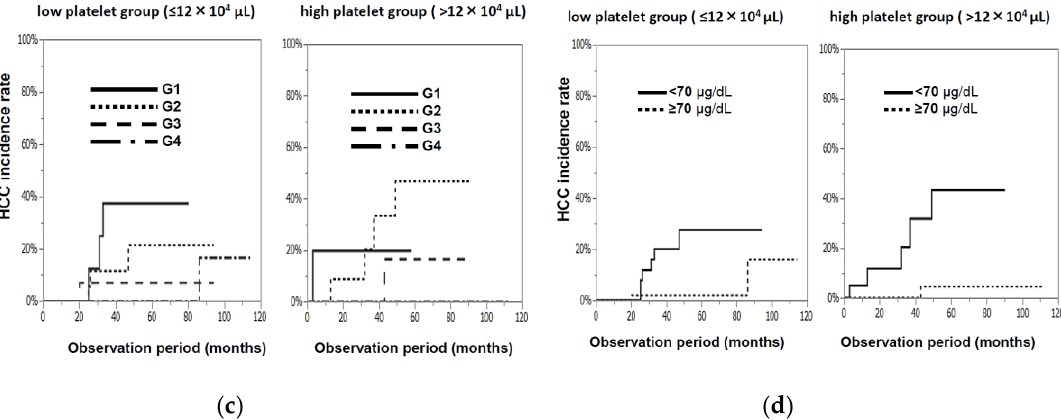
Figure 6. The cumulative incidence rates of events ( a ) and the incidence rates of HCC ( c ) (left panel) in the low-platelet count group and (right panel) the high-platelet count group (( a ) in both panels, G1/G2 groups vs. G3/G4 groups, p < 0.0001, ( c ) left panel, G1/G2/G3 groups vs. G4 group, p = 0.0172, and right panel, G1/G2 groups vs. G3/G4 groups, p = 0.0098). ( b , d ) The cumulative incidence rates of events ( b ) and HCC ( d ) (left panel) in the low-platelet count group and (right panel) the high-platelet count group, (low serum zinc concentration group and high serum zinc concentration group) (all panels, p < 0.0001).